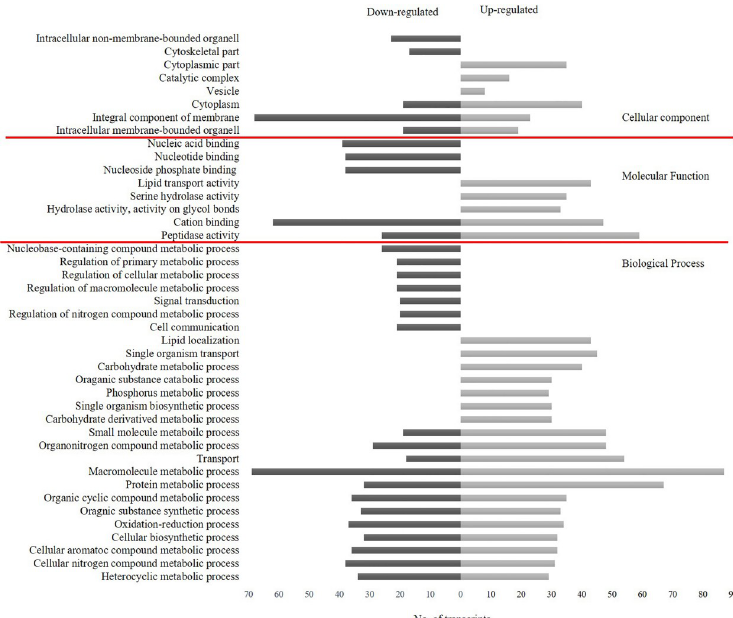
Fig 2. Number and functional categories of gene ontology terms assigned for up-regulated and down-regulated transcripts of CaCV-exposed Thips palmi at level 2.